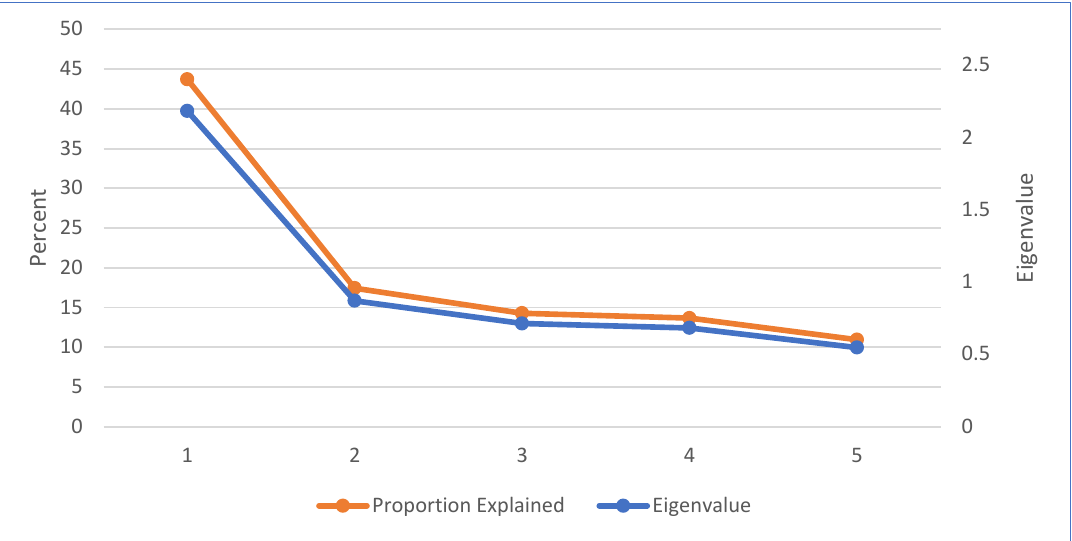
Figure 1. Percent of the total variance explained and eigenvalues from a principal component analysis using five well-being measures, by component. Notes: ATUS-WBM final activity sampling weights are used in this principal component analysis using five well-being measures (happy, tired, stressed, sad, and pained). N = 3037. For each component, the primary y-axis shows the percent of the total variance explained while the secondary y-axis shows the eigenvalue. Source: Authors’ calculations, using data from the BLS 2021 ATUS-WBM.